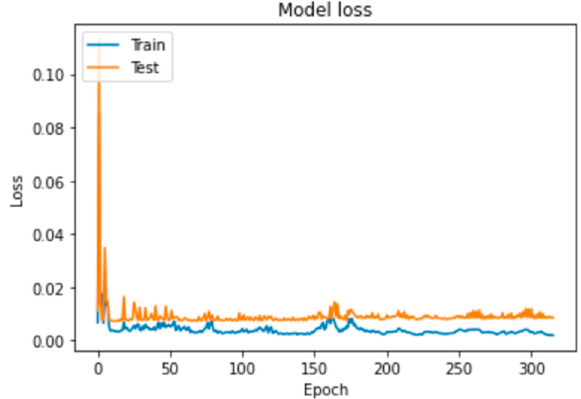
Figure 9. Repeated training data from the same data set.